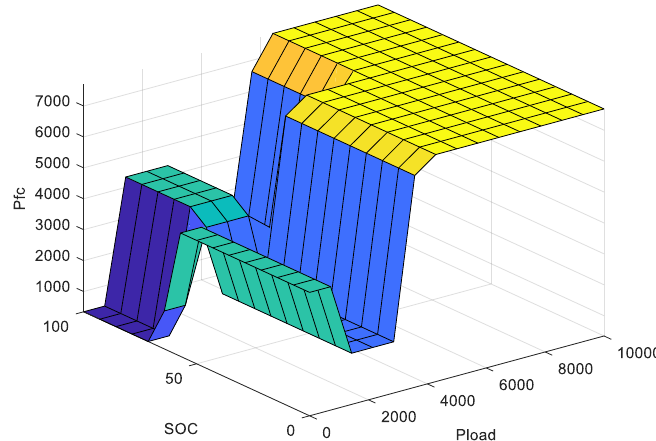
Figure 2. The 3D surface of the fuel cell (FC) system input-output membership functions (MFs).